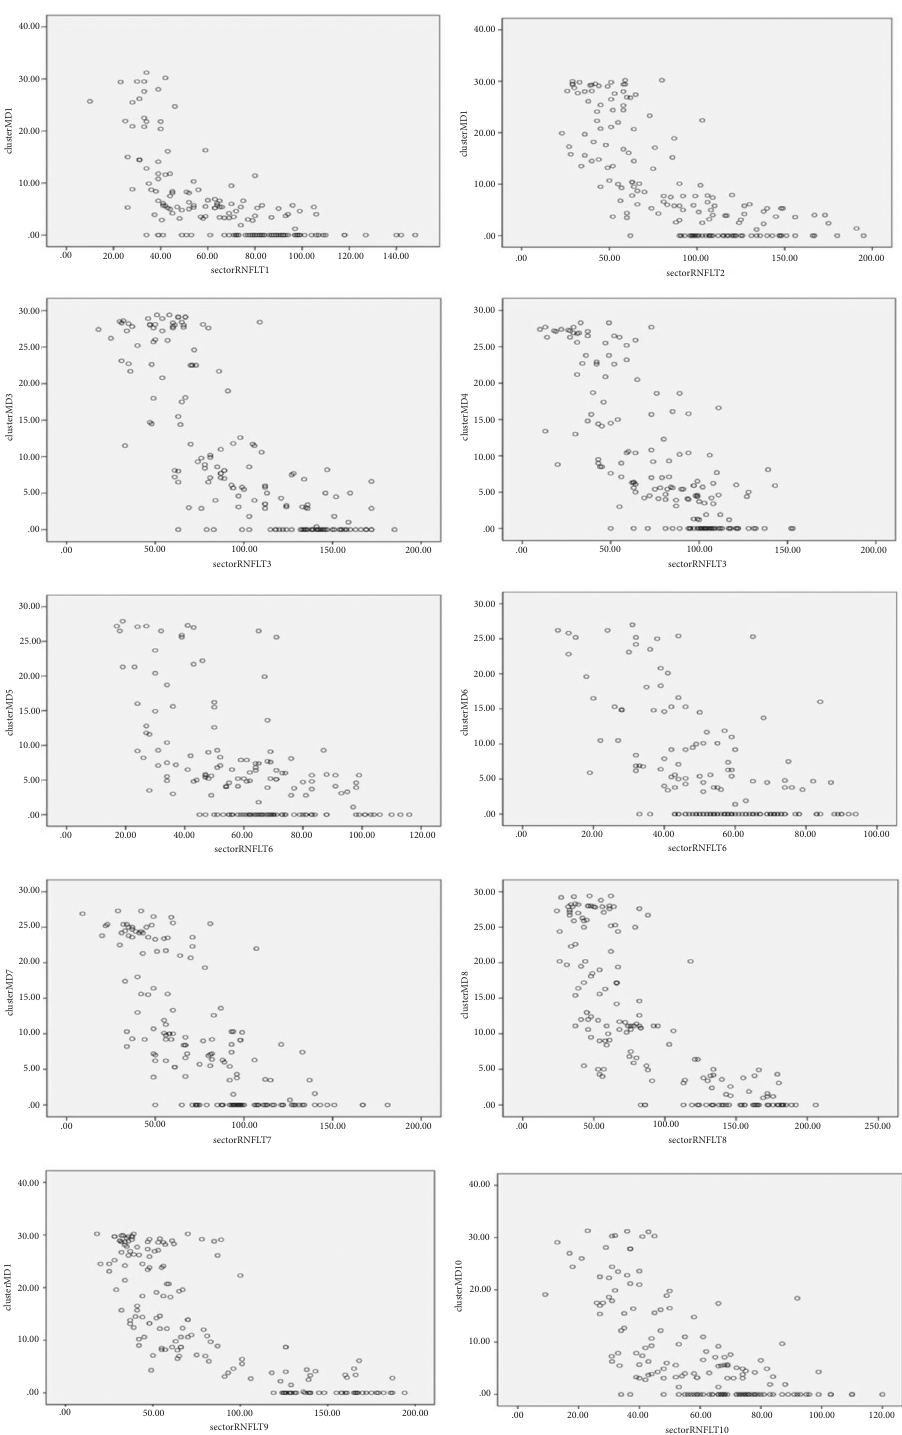
Figure 2: Scatter plots of sector retinal nerve fiber layer thickness (RNFLT, μ m) and cluster mean defect (cluster MD, dB) for 10 cluster- sector pairs in the total sample ( n �